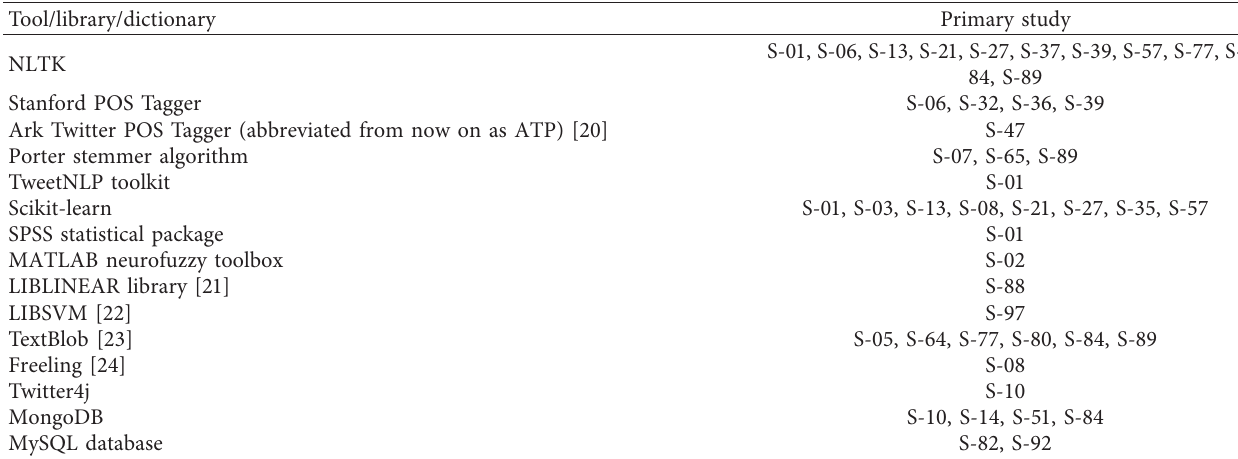
Figure 8: Election prediction techniques along with the reporting studies. Table 6: Tools/libraries/dictionaries along with the reported